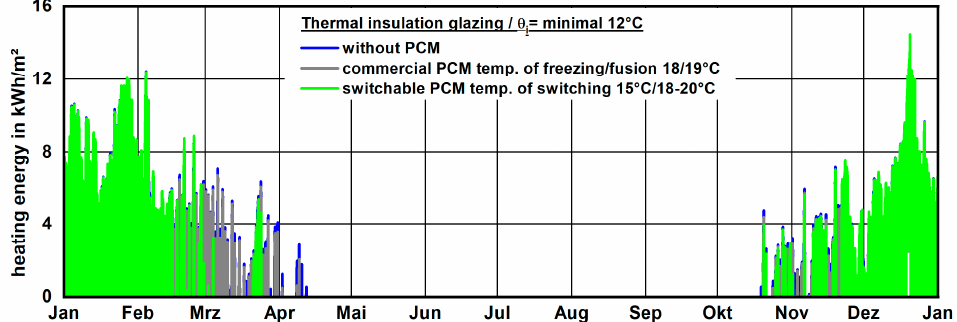
Figure 9. Comparison of the required heating energy during a year when using thermal insulation glazing without a PCM (blue), with a commercially available PCM (gray), and with a newly developed, programmable PCM (green).